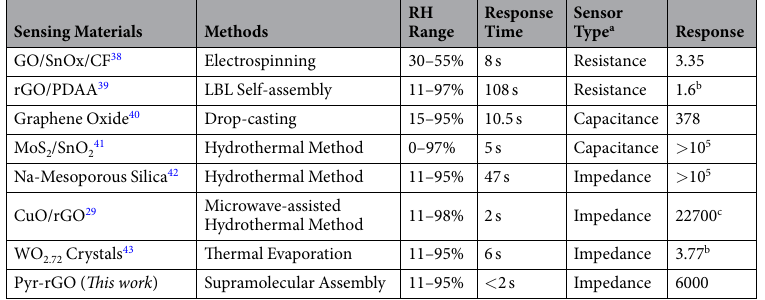
Table 1. Comparison in sensing performance towards various humidity sensors. a Three widely adopted humidity sensor types are listed in this table, which records the change of resistance, capacitance and the impedance respectively in humidity testing. b For the convenience of comparison, the evaluation of response is converted as the ratio of the resistance or impedance in high and low RH level. c The testing frequency is 10 Hz while the other humidity sensors of impedance type are tested in 100 Hz.